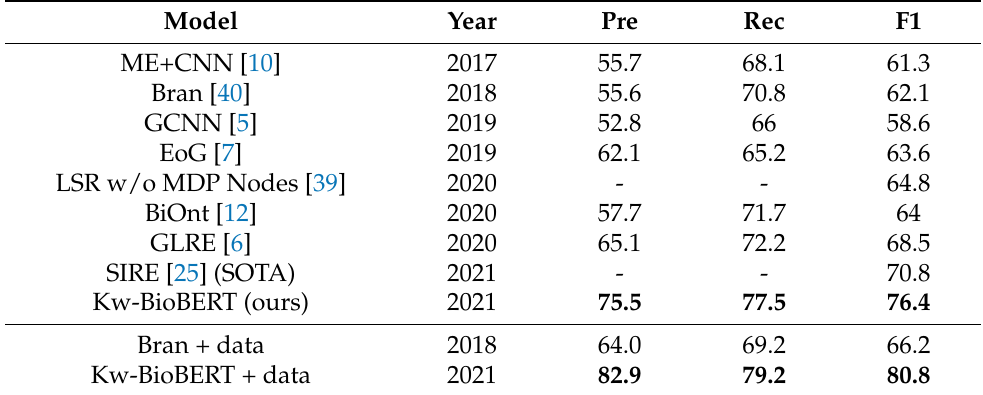
Table 6. The performance of the benchmarks and our method on the CDR test set. The highest value of each metric is marked in